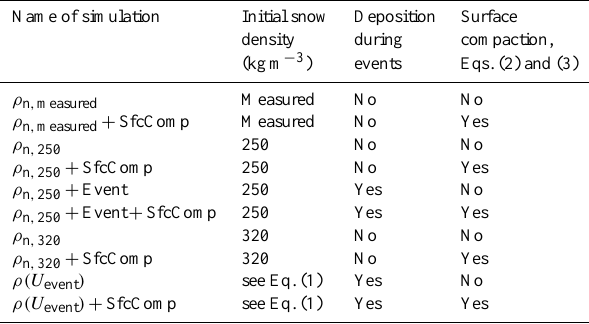
Table 2. All simulations performed to test the adaptations made to SNOWPACK. We define each simulation and summarize how snow density of new snow was initialized, if the snow was deposited at time of measurement or in events (Sect. 3.1) and if additional surface compaction (Sect. 3.2) was activated.